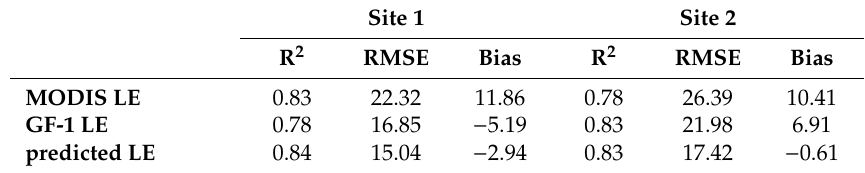
Figure 10. Comparisons between MODIS LE product, GF-1 LE Product and Scheme 2 simulated LE product with EC measurements. The top panel shows the time series of LE in 8-day averaged scale at ( a ) Site 1 ( b ) Site 2, the bottom panel shows the scatter plots of predicted LE with EC measurements in a daily scale at ( c ) Site 1 ( d ) Site 2. Table 2. Statistical comparison of the MODIS, GF-1 LE product and predicted LE for Scheme 2.